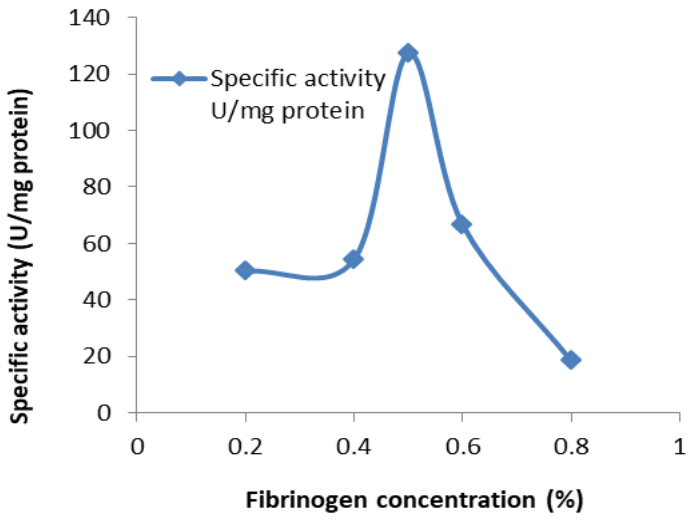
Figure 3: The optimum fibrinogen concentration for production.